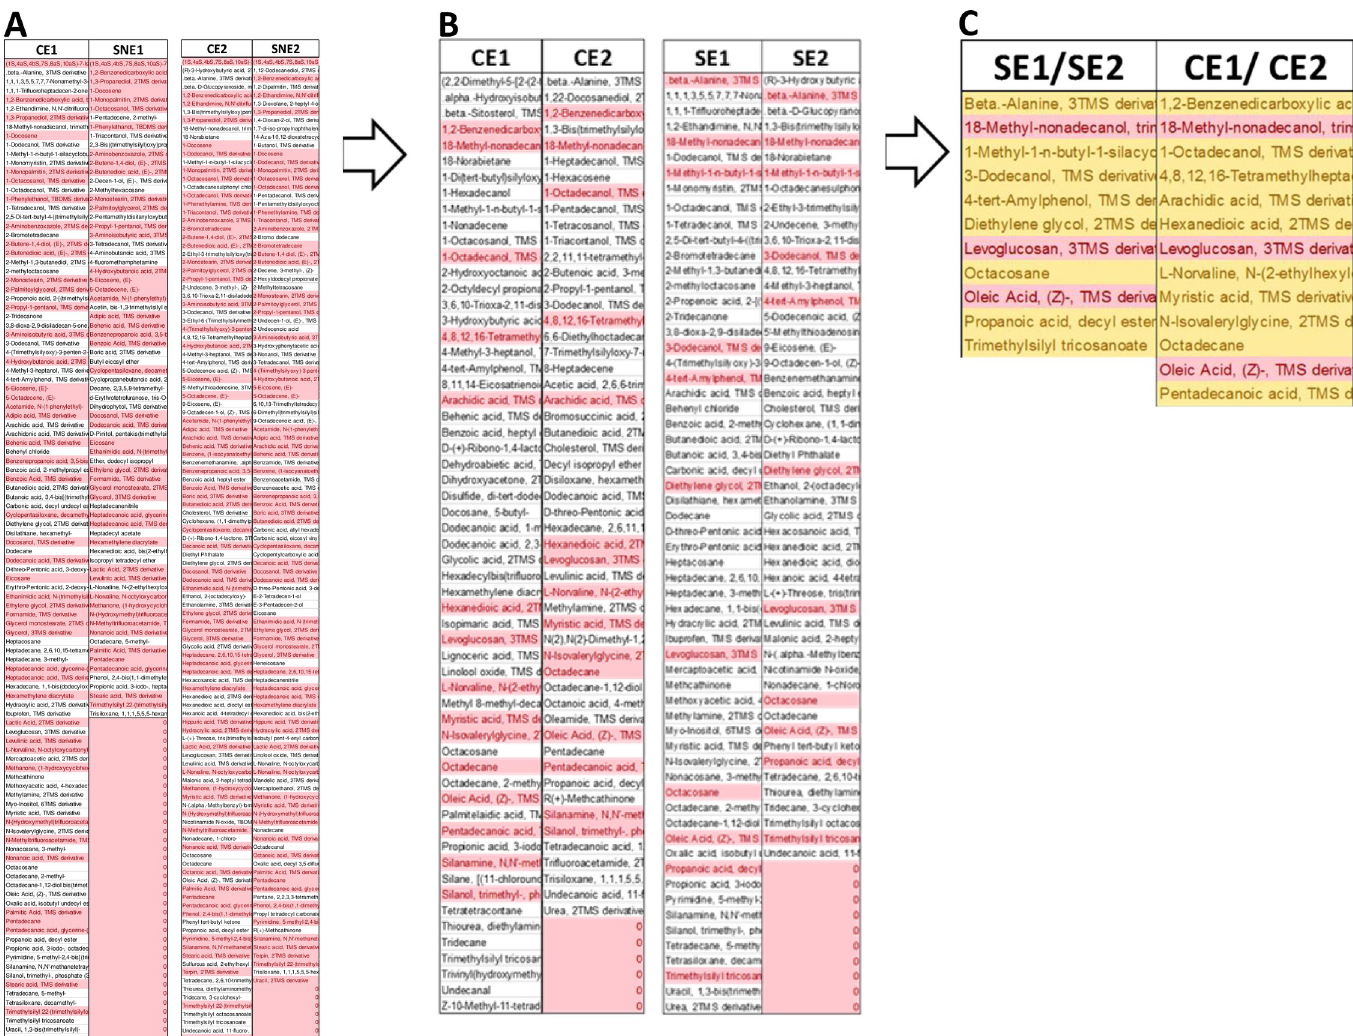
Fig 6. Identification of metabolites involved in biogenesis of AuNPs using GC-MS analysis. Metabolites (SNE1 and SNE2) extracted from the solution obtained after the generation of AuNPs were compared to the parent metabolites extracts (CE1 and CE2) used for their generation. The metabolite difference in the parent metabolites were selected and re-compared to metabolites extracted from cell-free supernatants (ES1 and ES3). Gold chloride was incubated with metabolites extracts dissolved in PBS for 4–6 days until the color changes. The cultures were spin down and the supernatant was collected. The supernatant was re-extracted with ethyl acetate prior to GC-MS analysis. The results obtained were compared with control extracts treated similarly but without gold chloride. (A) Metabolites comparison between gold chloride-treated versus non-treated samples. Light red-colored metabolites are shared metabolites between samples, while the uncolored metabolites are different. (B) Only metabolites identified from control samples (CE1 and CE2) but not the treated ones were compared to metabolites extracted from supernatants (SE1 and SE2). Light red-colored metabolites are shared metabolites between samples, while the uncolored metabolites are different. (C) Only shared metabolites were combined from supernatants versus cells. Light red-colored metabolites are shared metabolites between samples, while the orange metabolites are different.